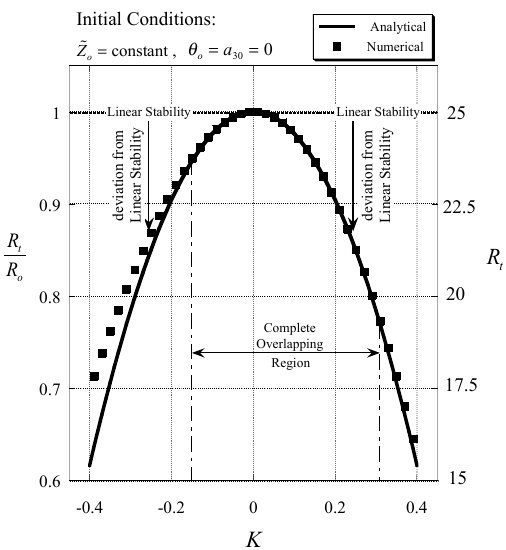
Figure 8. Transitional subcritical values of the scaled Rayleigh number R t as a function of the feedback gain controller parameter K corresponding to initial conditions of (cid:101) Z o = 1 = constant; θ o = a 30 = 0 [51]. (Reproduced with permission from Peter Vadasz, Transport in Porous Media; published by Spinger,